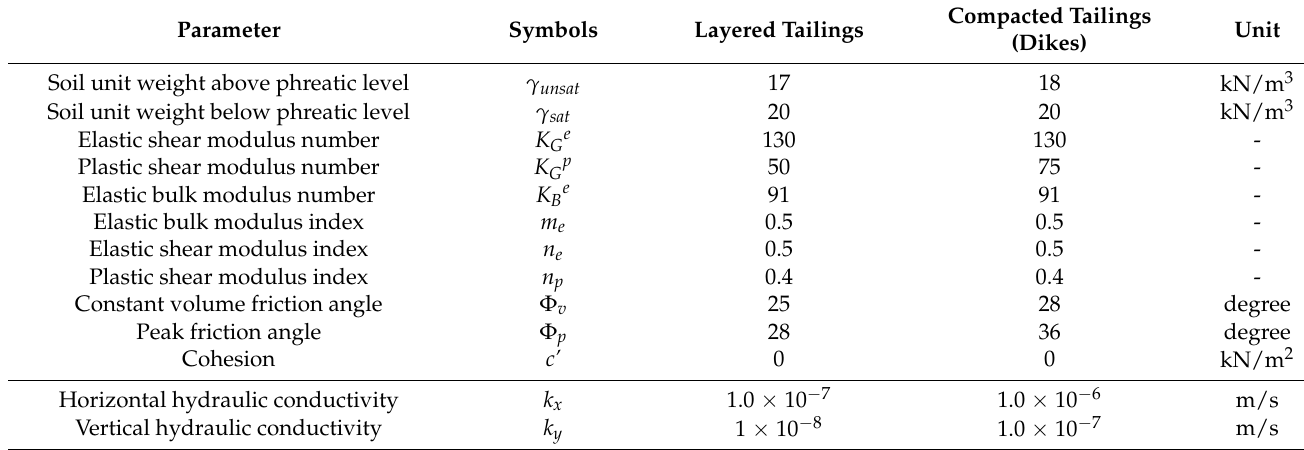
Table 2. Parameters of UBCSAND